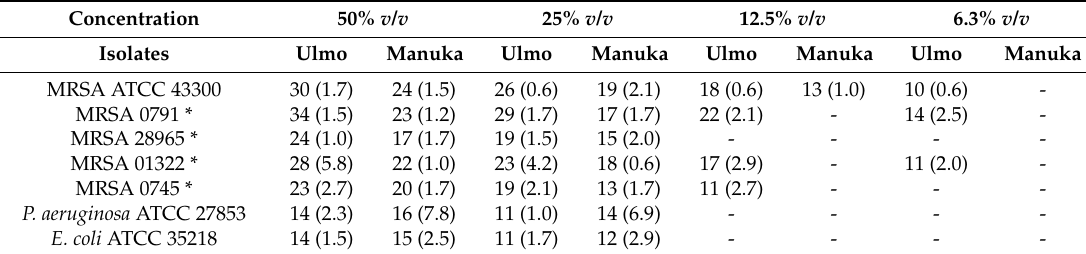
Table 1. Honeys inhibit bacterial growth. Zones of inhibition (diameter, in mm) of different concentrations of Ulmo and Manuka honey against various strains of MRSA. Standard deviations are shown in parentheses. “-” indicates no inhibition at that concentration. “*” indicates a clinical isolate. Reproduced with permission from Sherlock et al. Complementary and Alternative Medicine ; published by BMC, 2010. Concentration 50% v / v 25% v / v 12.5% v / v 6.3% v / v Isolates Ulmo Manuka